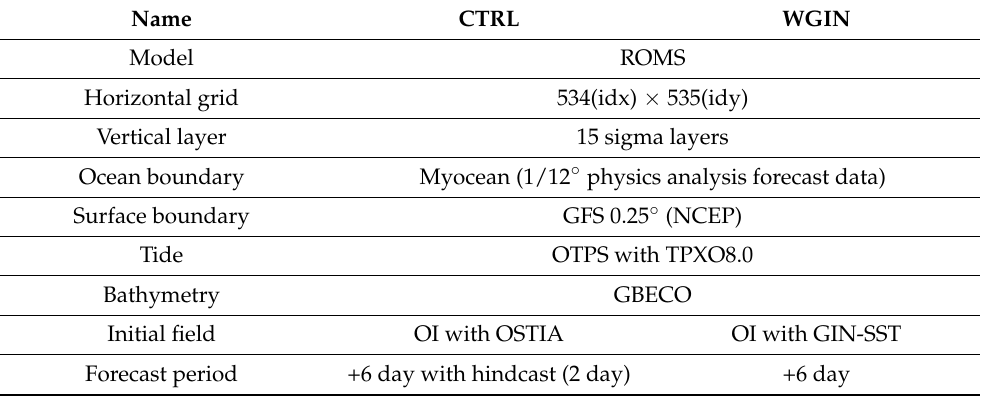
Table 1. Comparison of the configuration of the two systems, CTRL and WGIN.